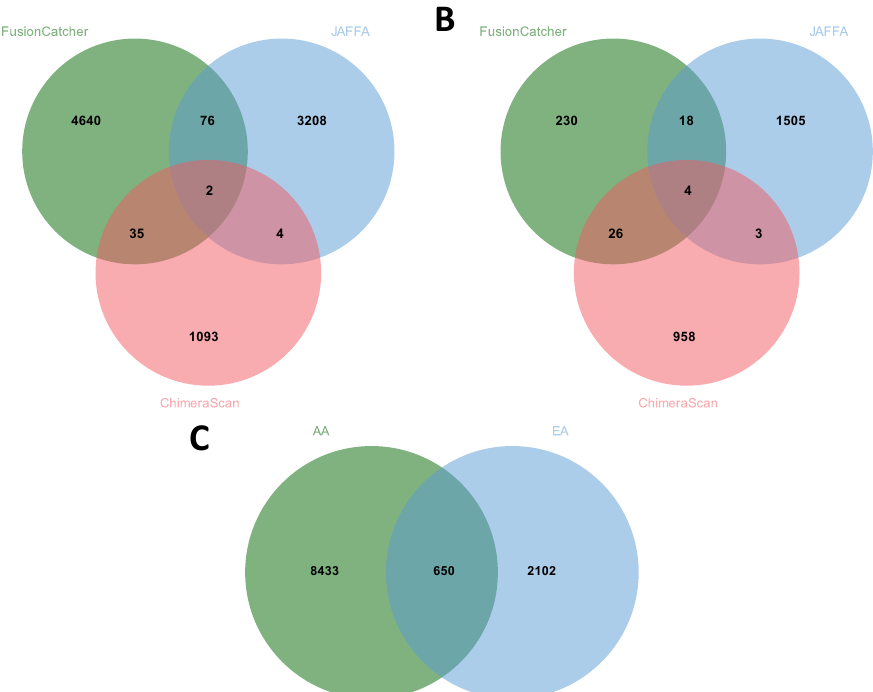
Figure 4. ( A ) Comparison of fusions detected by FusionCatcher, JAFFA, and ChimeraScan in AA patients. Two shared fusion genes were predicted by these tools in AA patients ( NAIP:OCLN and PDE1C:DNAJC6 ). ( B ) Comparison of fusions detected by FusionCatcher, JAFFA, and ChimeraScan in EA patients. Four shared fusion genes were predicted by these tools in EA patients (Shared fusions— NAIP:OCLN , FOXP2:CREM , KANSL1:ARL17B , and KANSL1:ARL17A ). ( C ) Comparison of detected fusions in AA and EA patients across all four tools. Low-confidence fusions have been excluded from all the